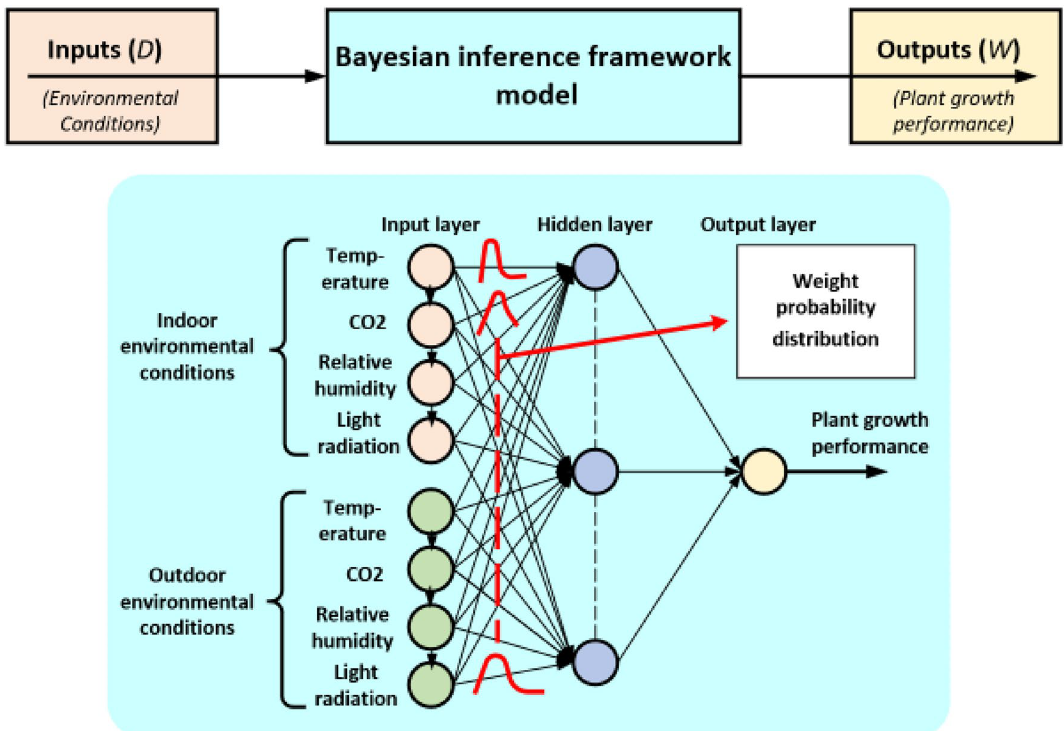
Figure 3. A simple block diagram of the Bayesian inference framework for updating probability distribution over the weights with multi-inputs and single output. Back-propagation in neural network structure for modelling lettuce growth is used in this framework. The network has three layers; input layer for the environmental conditions inside and outside of the CSG, one hidden layer and one output layer for the plant